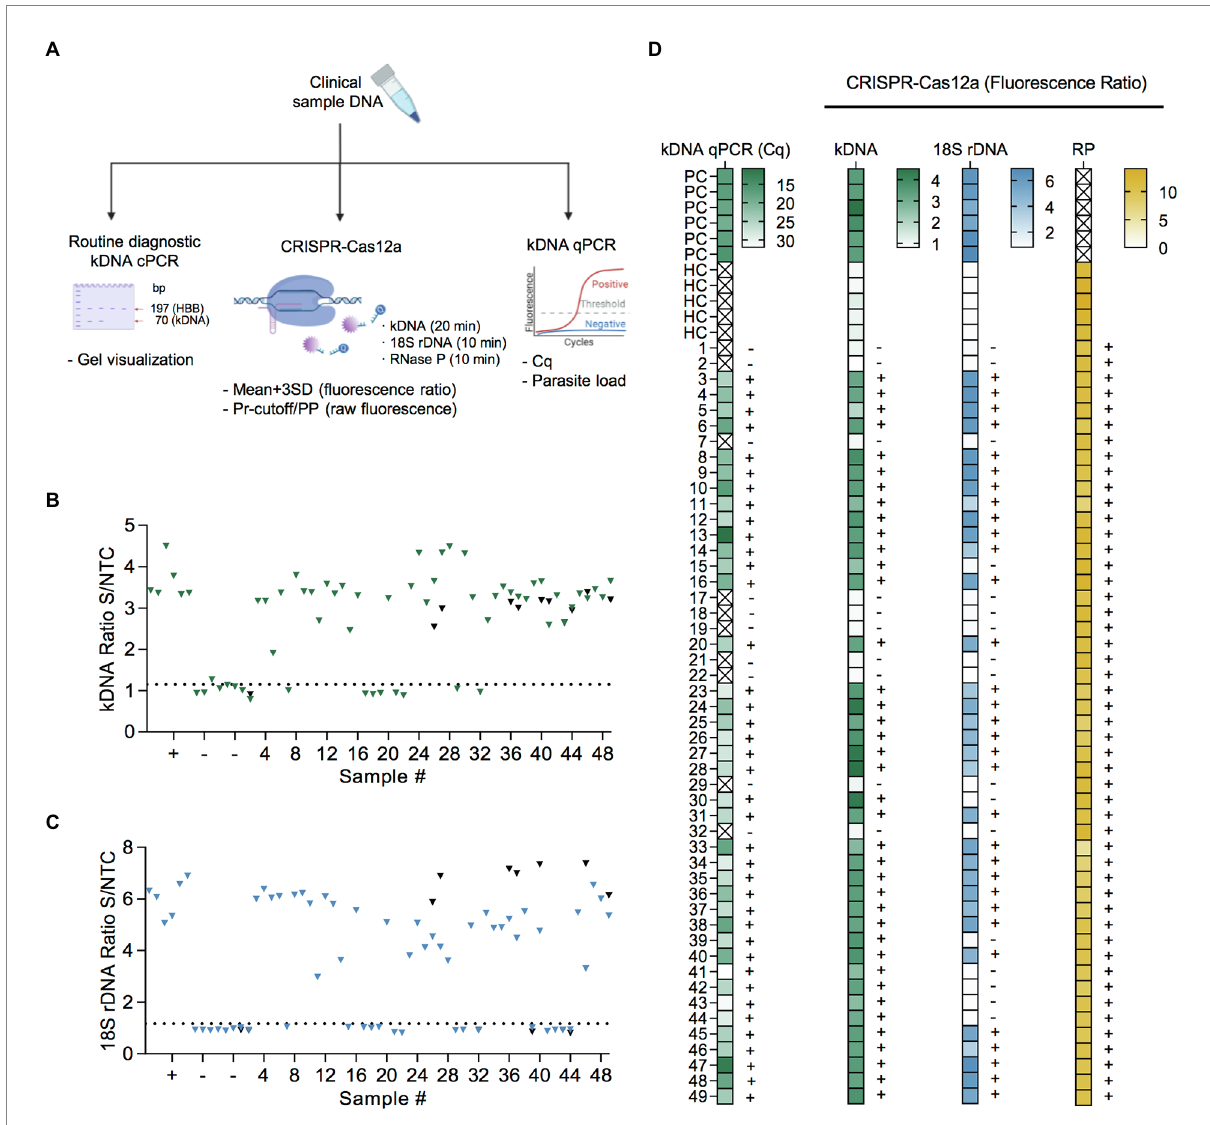
FIGURE 5 Performance evaluation of PCR/CRISPR assays for detection of Leishmania DNA targets in clinical samples. (A) Sample analysis workflow including molecular analyses (kDNA cPCR, kDNA qPCR, and PCR/CRISPR targeting Leishmania kDNA and 18S rDNA or human RNase P gene) and data analysis (see Materials and Methods for more details). Figure created with BioRender.com. (B,C) Extracted DNA from 49 clinical samples was subjected to PCR amplification using primers specific to kDNA (B) and 18S rDNA (C) of Leishmania , followed by Cas12a-based detection. Fluorescence measurements were made on the Synergy H1 plate reader. Data shown represent the fluorescence ratio from Cas12a reactions. The dashed lines indicate the positive threshold cutoff value (mean of the fluorescence ratio of negative clinical samples +3SD; n = 10) for detection of Leishmania targets (cutoff value = 1.151 for kDNA and 1.171 for 18S rDNA). +, positive control ( L. ( V. ) braziliensis M2904 gDNA; n = 6); − , negative control (human PBMC gDNA; n = 6). A subset of clinical samples was retested (black symbols). Full time course data for a group of clinical samples are provided in Supplementary Figure S4. (D) Heat maps displaying qPCR and PCR/CRISPR data from clinical samples. Left panel , the color scale represents quantification cycle (Cq) values determined by kDNA qPCR. The X mark inside the box symbol indicates that no Cq value was obtained. Second-fourth panels , the color scale represents fluorescence ratio values from Cas12a reactions for Leishmania kDNA and 18S rDNA targets and the sample control, human RNase P (RP) gene, respectively. The X mark inside the box symbol in the RP gene heatmap indicates not applicable. The detection threshold of the Cas12a assay on the Leishmania targets was set as the mean of the fluorescence ratio of negative clinical samples ( n = 10) + 3SD. The positive threshold for the RP gene was set as a fluorescence signal of 5-fold above background (i.e., fluorescence ratio > 5; Khan et al., 2021). The test results (+, detected; − , not detected) are indicated on the right side of the heat maps. Samples are coded as 1–49. PC, positive control ( L. ( V. ) braziliensis M2904 gDNA for the PCR/CRISPR assays; DNA from a biopsy specimen positive for Leishmania by kDNA cPCR used for the qPCR assay). HC, human PBMC gDNA. See Supplementary File S2 for the complete dataset of this